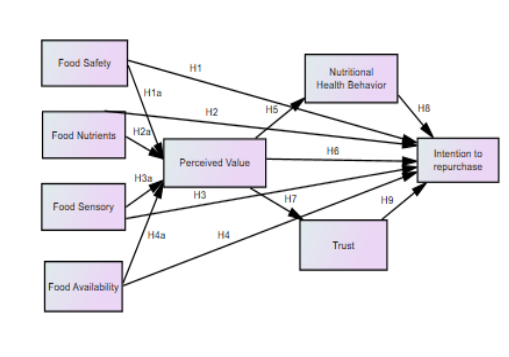
Fig. 1. Proposed Conceptual